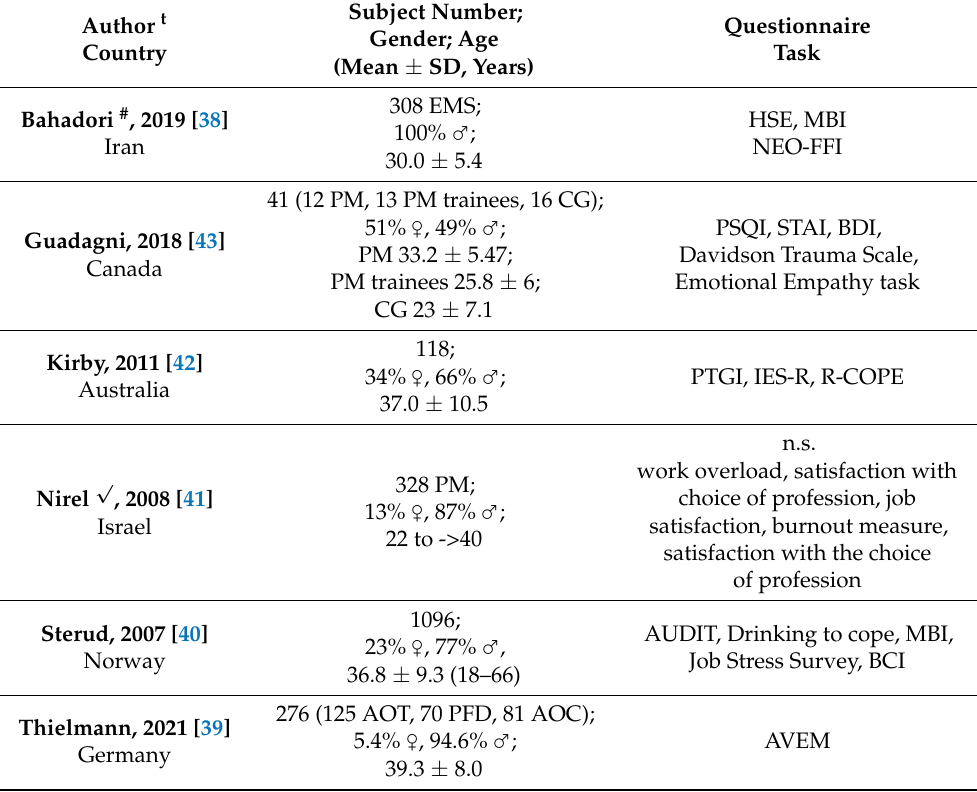
Table 1. An overview of the included studies with thematic of behavior (the results are shown in Supplementary File